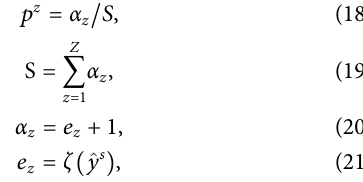
Frontiers in Genetics |